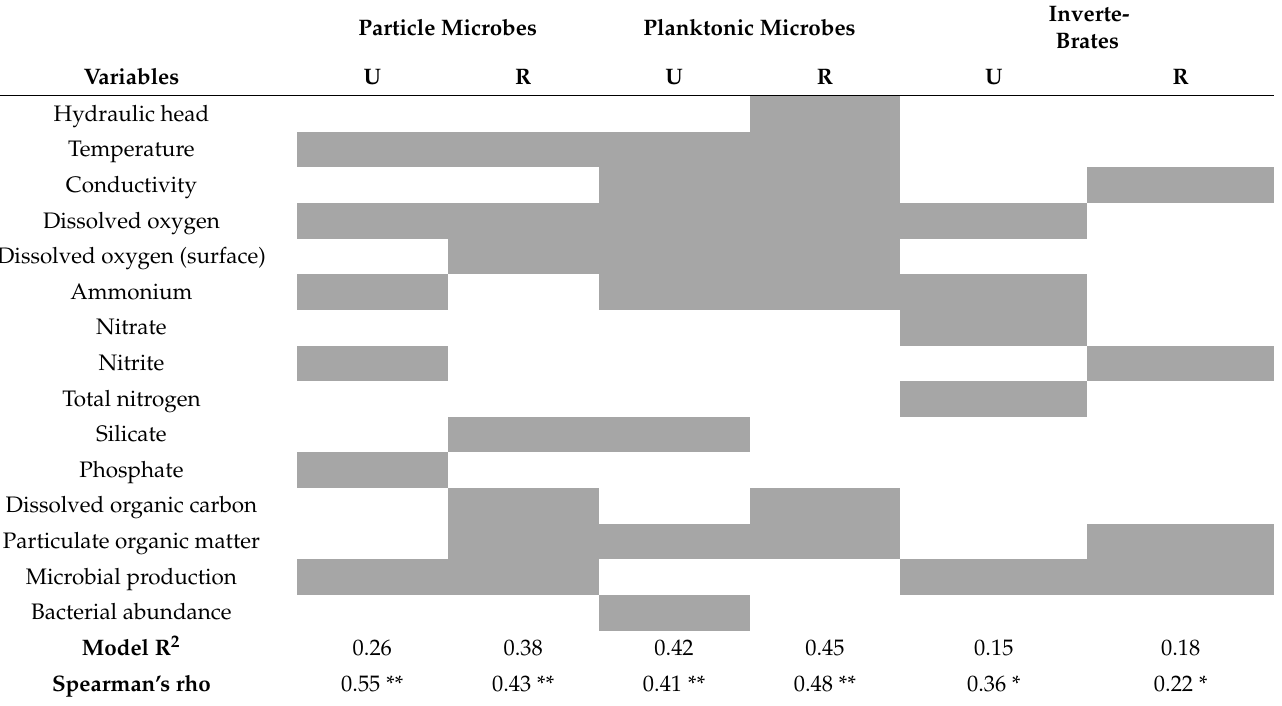
Table 3. Linkage of environmental variables to multivariate microbial and invertebrate assemblages by distance-based linear modeling and matrix correlations. Dark shading indicates significant environmental variables included in the optimum linear model based on AIC (delta AIC ≥ 0.5). Spearman’s rho value is based on matrix correlation using the environmental variables included in the model. ** indicates p < 0.01; * indicates p < 0.05. Results are reported by restoration status (U = unrestored, R = restored) for all sites combined. Unless otherwise indicated, environmental variables pertain to the HZ. Inverte- Particle Microbes Planktonic Microbes Brates Variables U R U R U